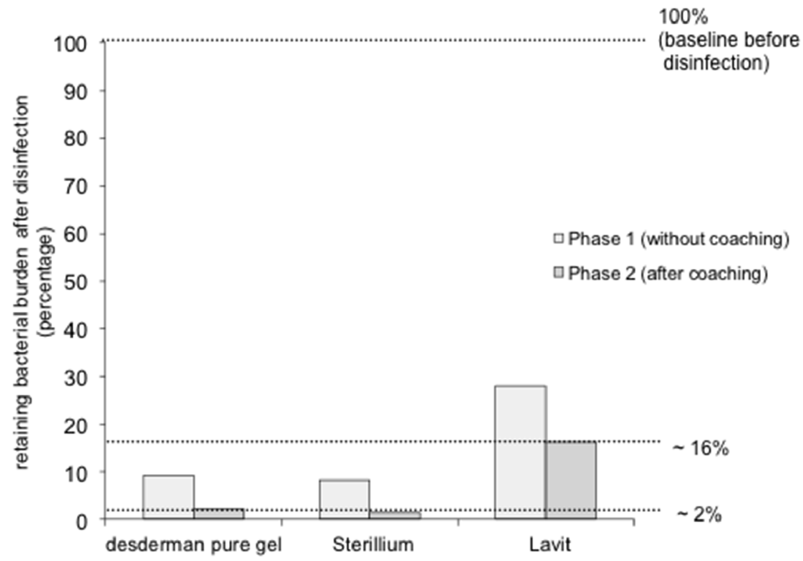
Figure 5. Relative remaining bacterial burden after disinfection. The sum of bacterial colonies in one group was taken as a baseline before disinfection (100%) and relative retaining bacterial burden was calculated with the sum of bacterial colonies of the same group after disinfection. After phase 1 (without explaining the EN1500 technique) relative retaining bacterial burden was 6.4%, 8.2% and 28.0% for desderman pure gel, Sterillium and Lavit, respectively. After phase 2 (disinfection according to EN1500) relative retaining bacterial burden was 2.1%, 1.5% and 16.2% when desderman pure gel, Sterillium or Lavit were used.